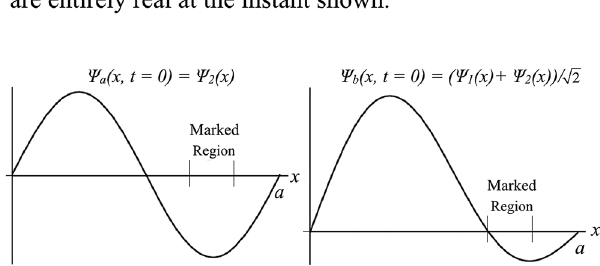
FIG. 5. Does the probability of finding a particle in the marked region depend on time? In this problem, student difficulties indicate transition error and displacement error. Figure originally from Ref.